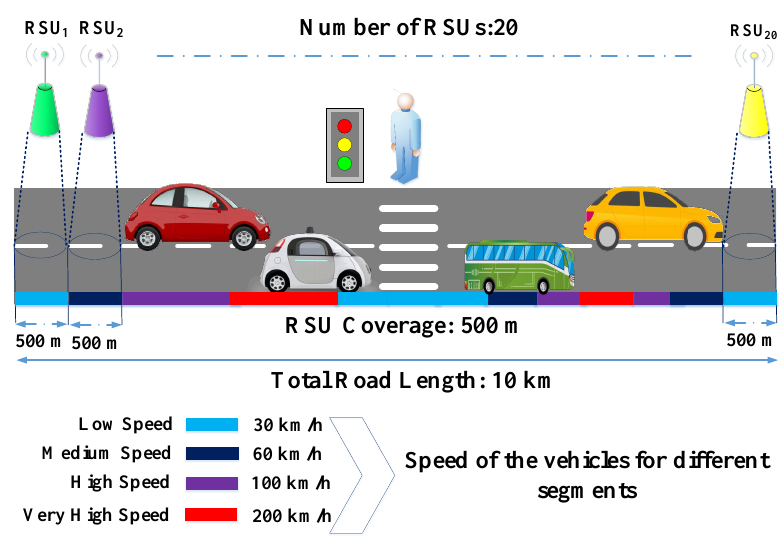
Figure 3. Vehicle movement mode for the simulation.